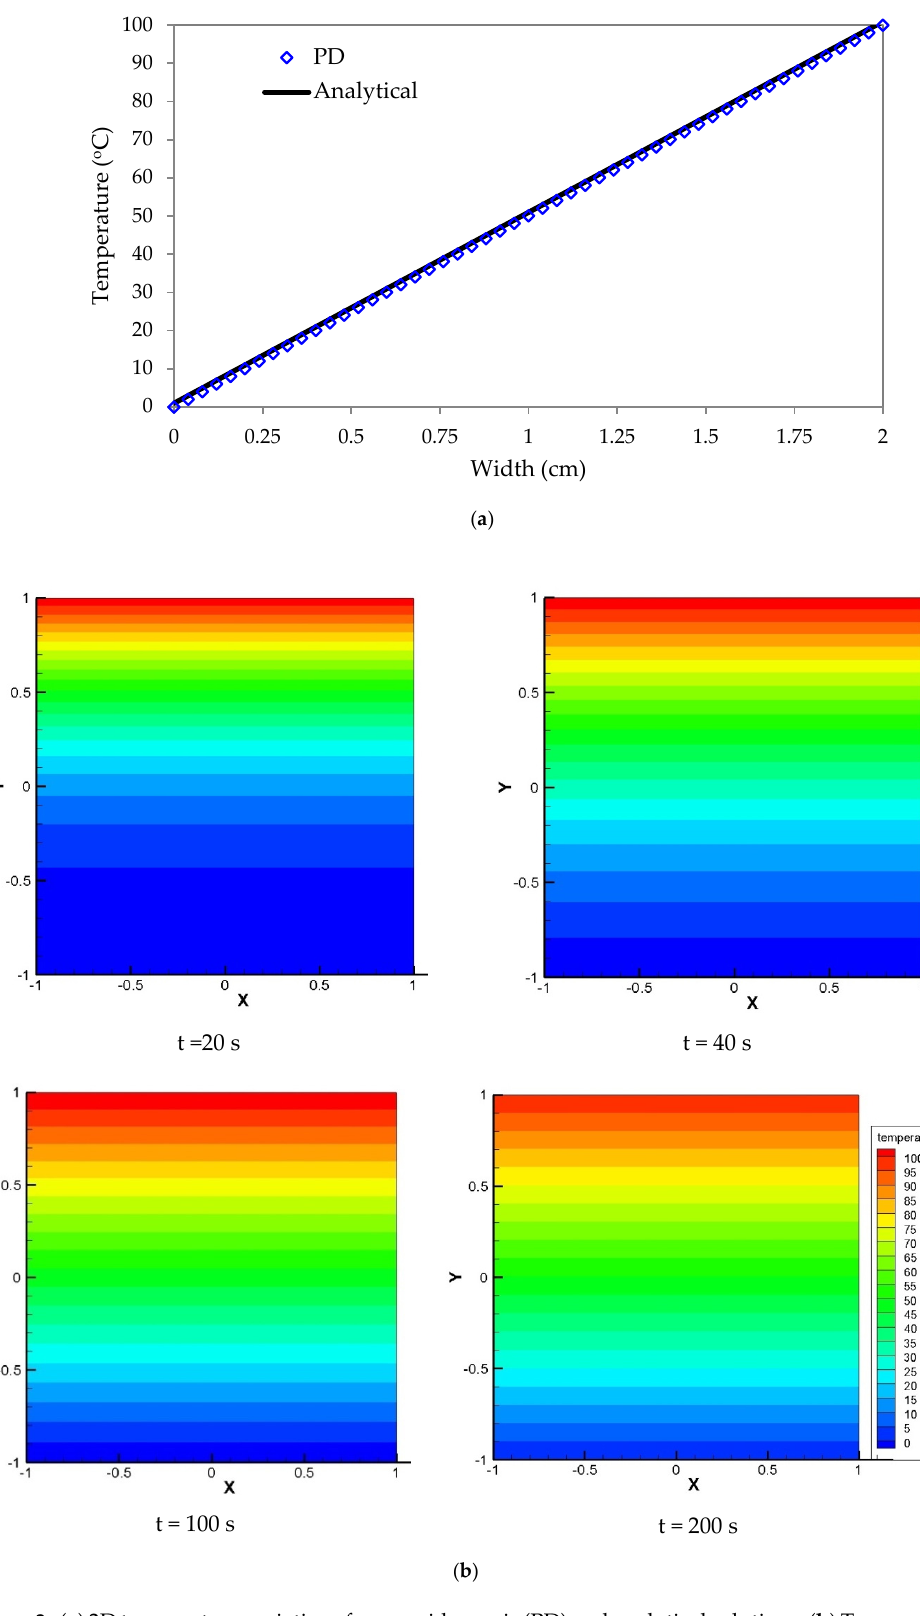
Figure3. ( a ) 2Dtemperature variationsfrom peridynamic (PD)and analytical solutions, ( b ) Temperature Figure 3. ( a ) 2D temperature variations from peridynamic (PD) and analytical solutions, ( b )